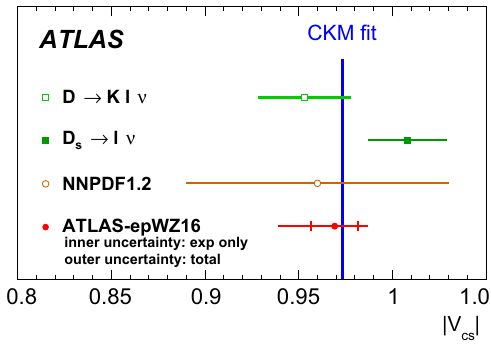
Fig. 32 | V cs | asdeterminedintheglobalCKMfitcitedbythePDG[39] ( blue vertical line ) compared to extractions from D s → (cid:3)ν and D → K (cid:3)ν decays [39] and the NNPDF1.2 fit [147]. The ATLAS-epWZ16 fit result is shown with uncertainty contributions from the experimental data ( inner error bar ) and the total uncertainty including all fit and further theoretical uncertainties ( outer error bar ). The uncertainty in | V | from the CKM fit with unitarity constraint is smaller than the cs width of the vertical line